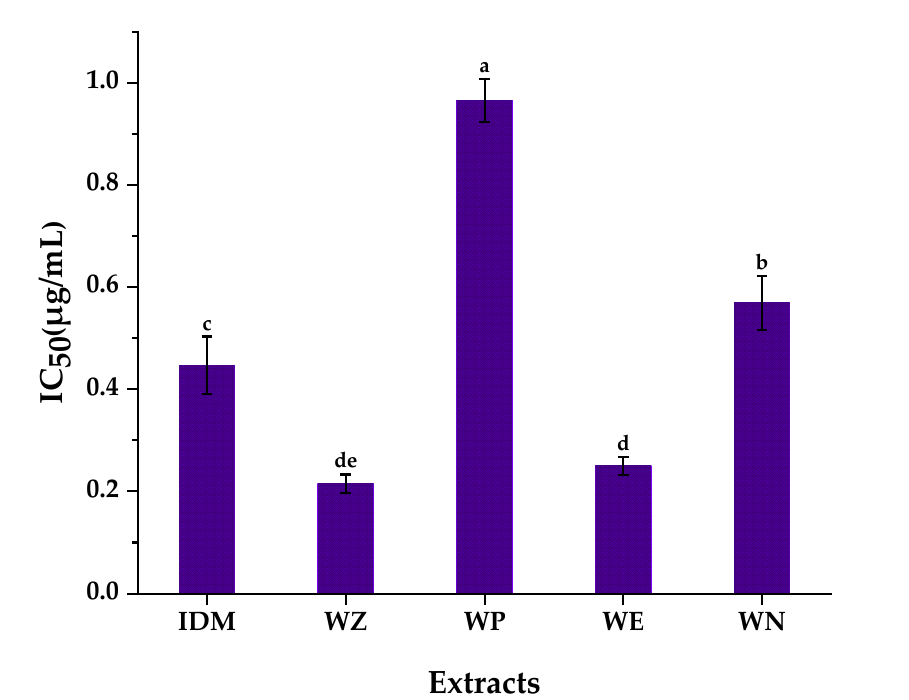
Figure 1. Anti-inflammatory activities of different extracts from stem barks of W. ugandensis . IDM: Indomethacin; WZ: 95% ethanol crude extract; WP: petroleum ether fraction; WE: ethyl acetate fraction; WN: n -butanol fraction; Means labelled by different letters ( a–e ) were significantly different at a level of p < 0.05 (n = 3) by DMRT (Duncan’s multiple range test).